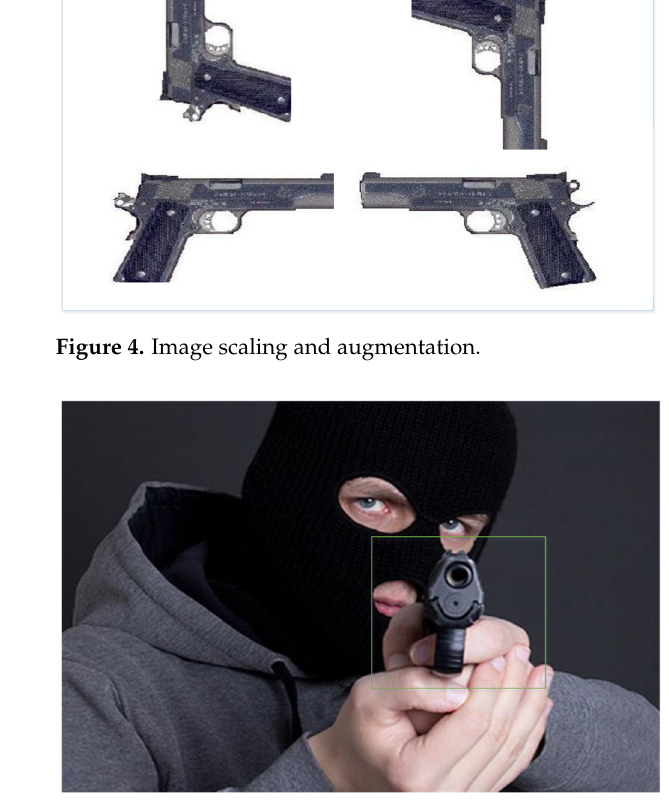
Figure 5. Image annotation and labelling.